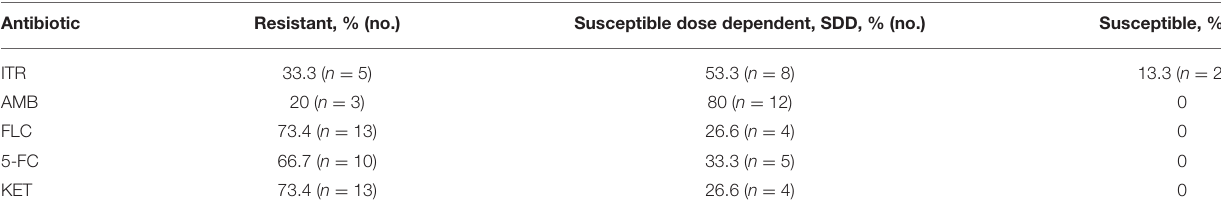
TABLE 3 | Results of antimicrobial susceptibility tests of C . krusei isolates ( n = 15).